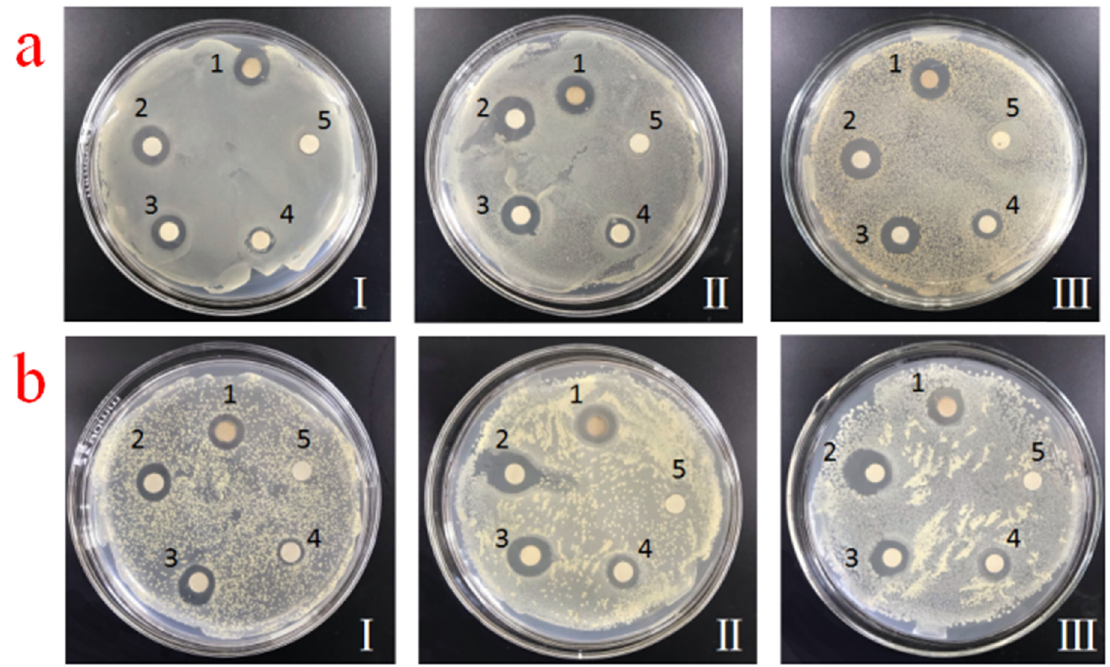
Figure 6: Representative images of agar plates containing ( 1 ) CQDs/mesoporous SiO 2 /Ag NPs, ( 2 ) Ag NPs, ( 3 ) mesoporous SiO 2 /Ag NPs, ( 4 ) CQDs/mesoporous SiO 2 and ( 5 ) CQDs, and inhibition zones for ( a ) E. coli and ( b ) S. aureus （ diluted 10 times ( Ⅰ ) , 10 2 times ( Ⅱ ) , and 10 3 times ( Ⅲ ) , respectively )